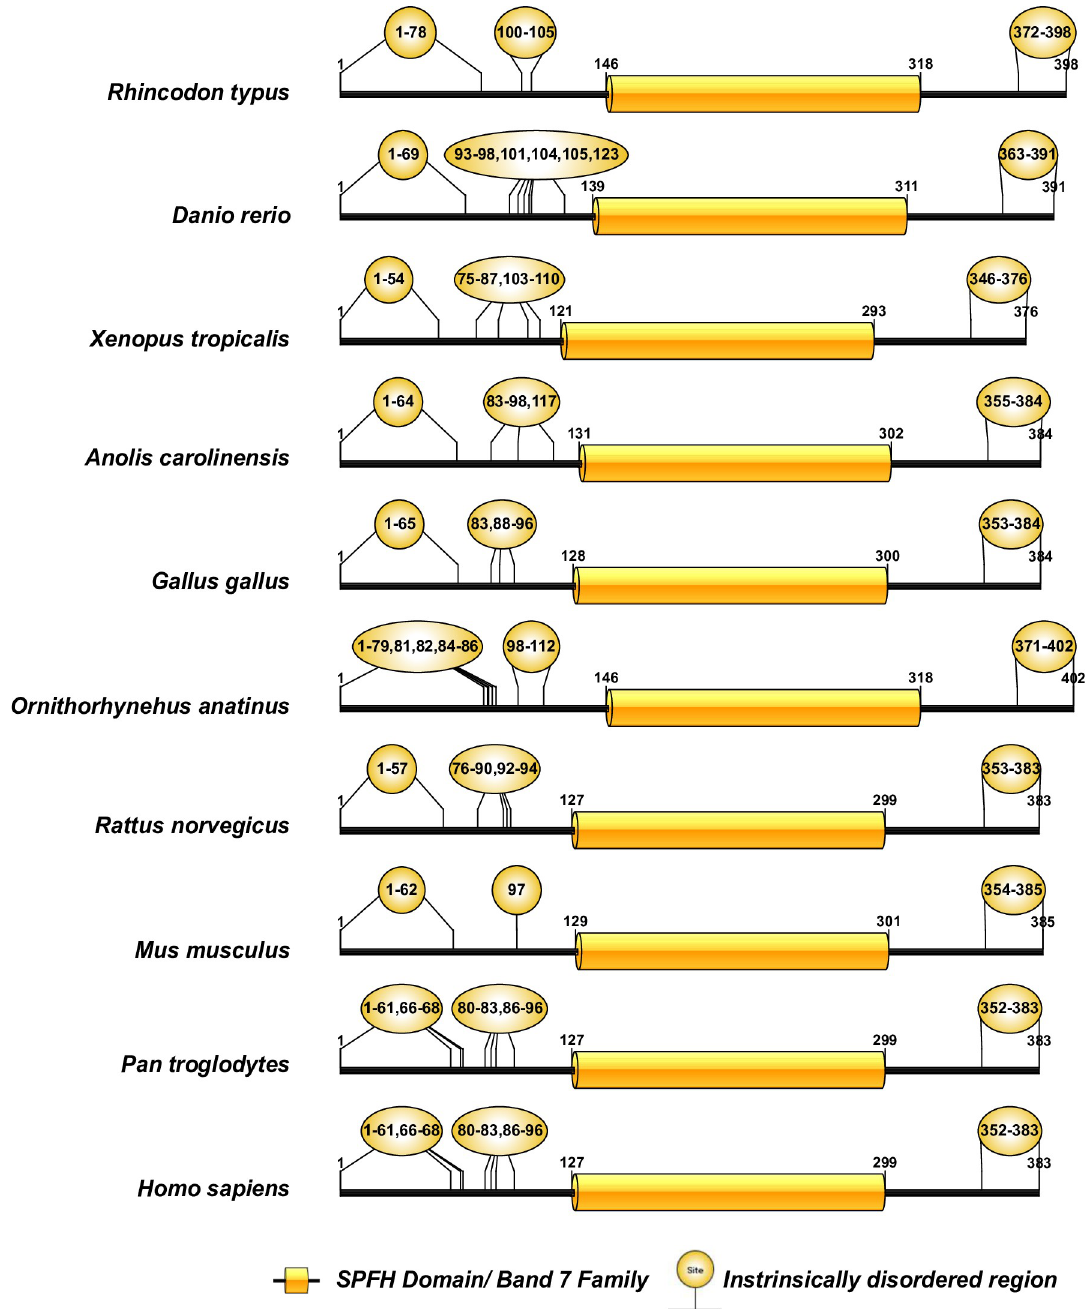
Fig 5. Domain organization of podocin sequences of the chordate phylum. Note: Yellow bubbles represent the intrinsically disordered regions.